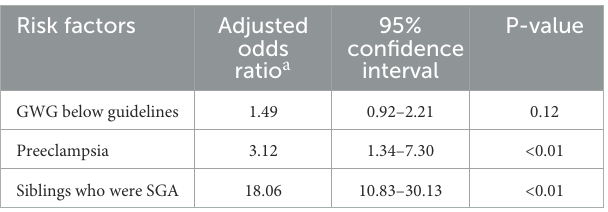
TABLE 5 Binary logistic analysis for the associations between maternal complications and SGA infants ( N = 1,651). Risk